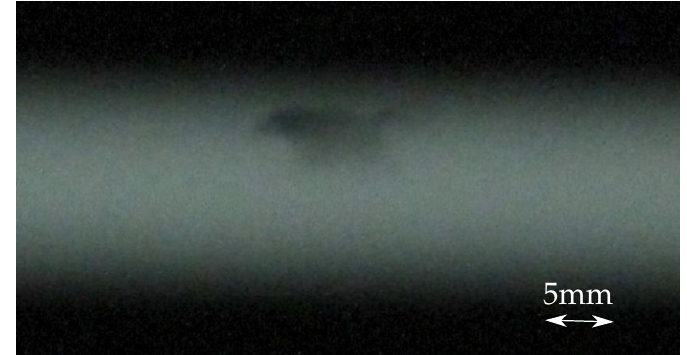
Figure 12. Computed tomography (CT) scan of large-scale specimen #30.